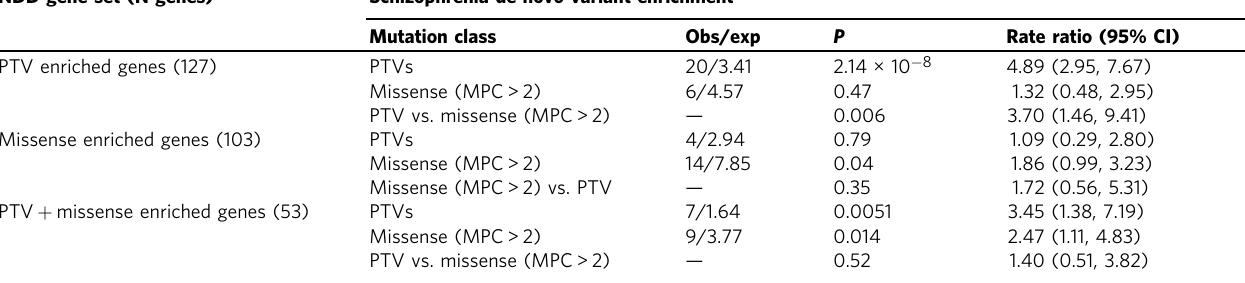
Table 1 Enrichment of schizophrenia de novo variants in neurodevelopmental disorder (NDD) associated genes. NDD gene set (N genes)